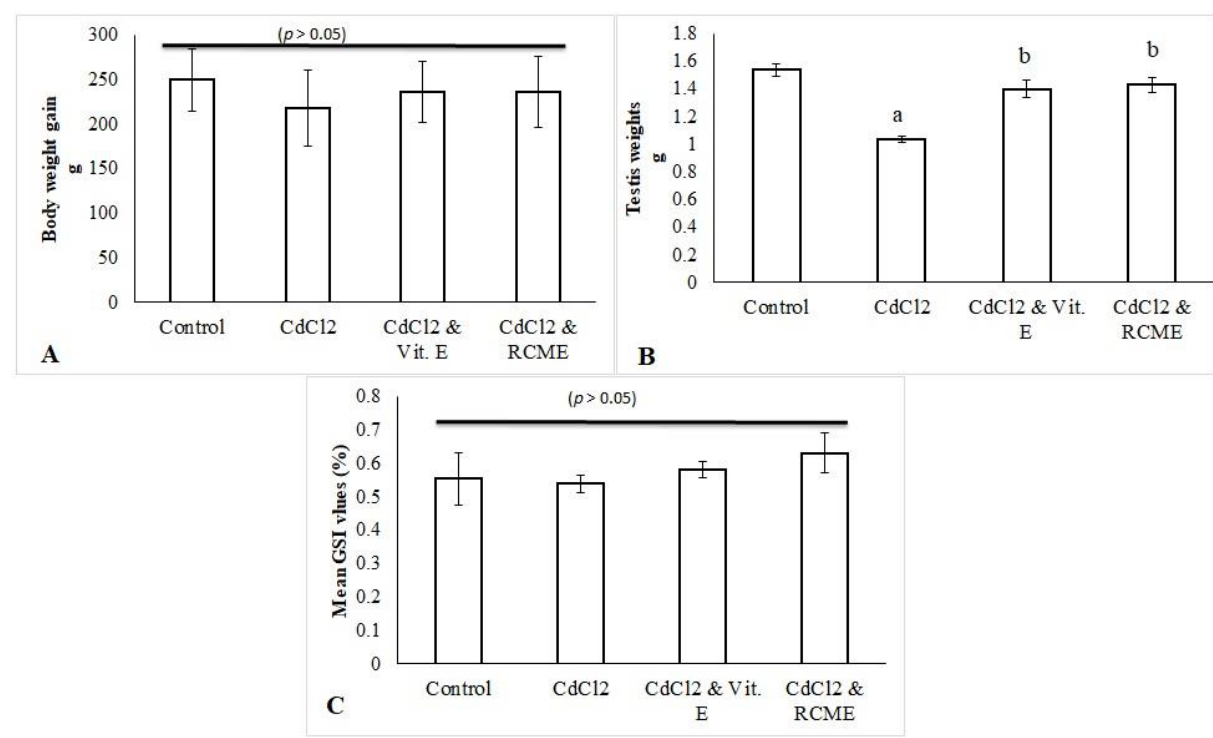
Figure 3. Mean values in grams of body weight gain ( A ) and testes weights ( B ) as well as the mean values of GSI ( C ) in control and treated groups. Each bar represents the mean ± SEM. a. p < 0.05 versus normal control. b. p < 0.05 versus CdCl 2 group. RCME: Red carrot methanolic extract; Vit. E: Vitamin E; GSI: gonadosomatic index.